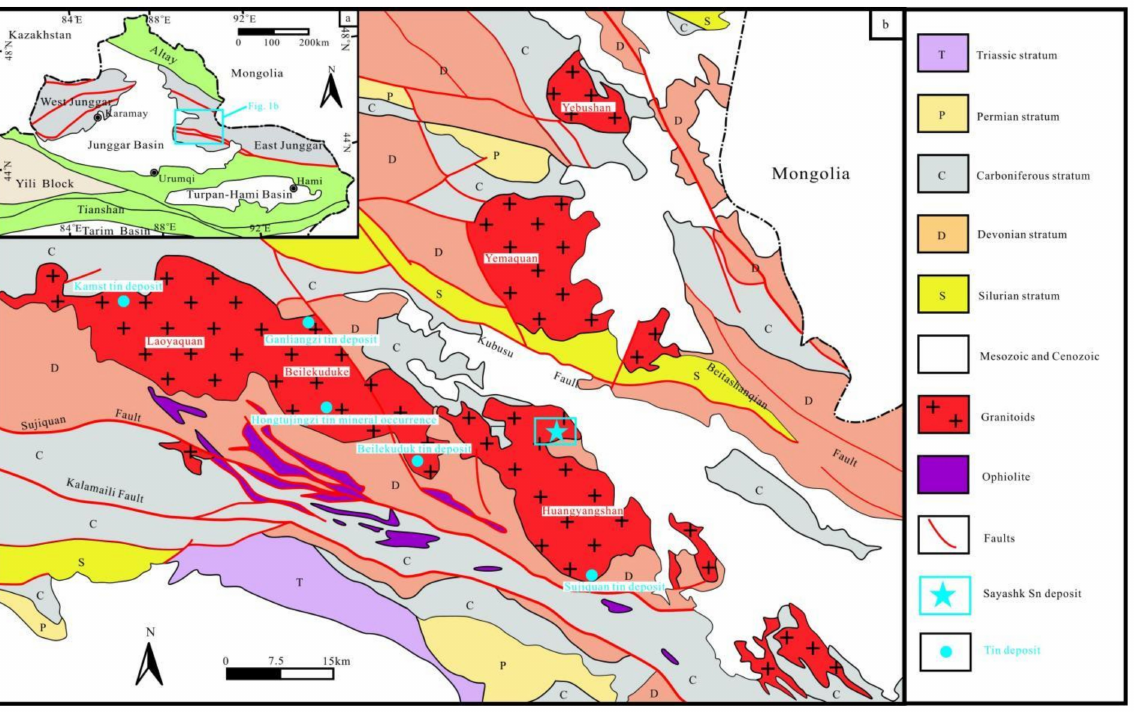
Figure 1. ( a ) Geological map of Xinjiang (modified after [42]). ( b ) Simplified geological map of the Kalamaili area, eastern Junggar (modified after